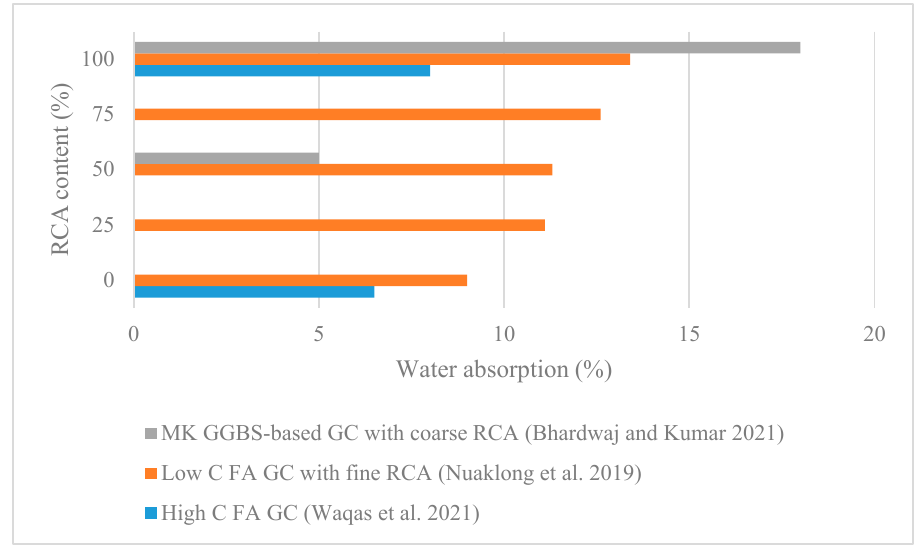
Figure 8. Effect of RCA content on water absorption [33,36,74].